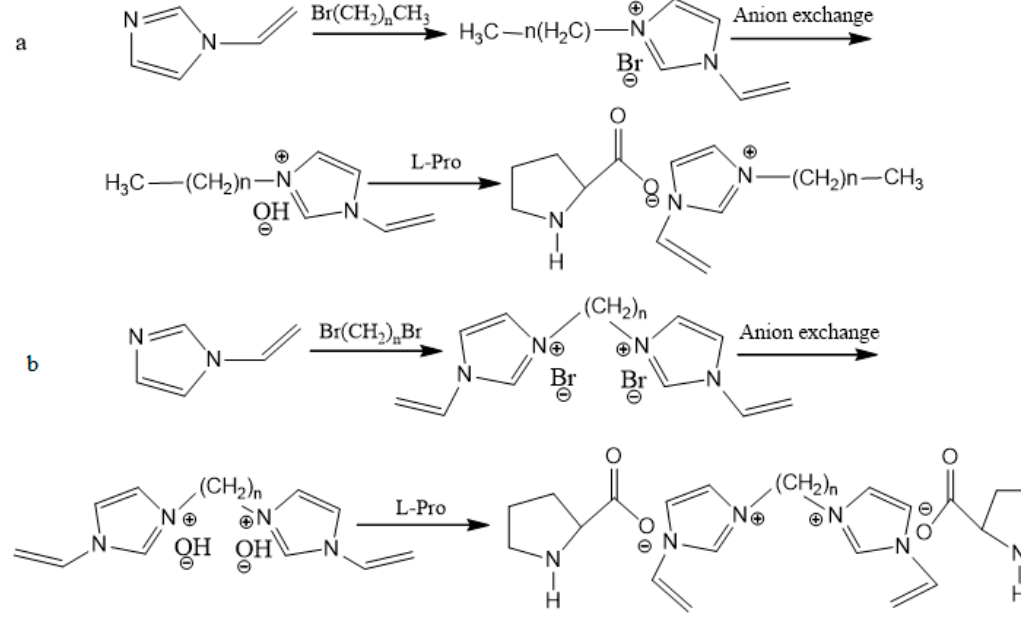
Figure 1. The synthesis of ( a ) ViImCn-L-Pro and ( b ) (ViIm) 2 C n (L-Pro) 2 .